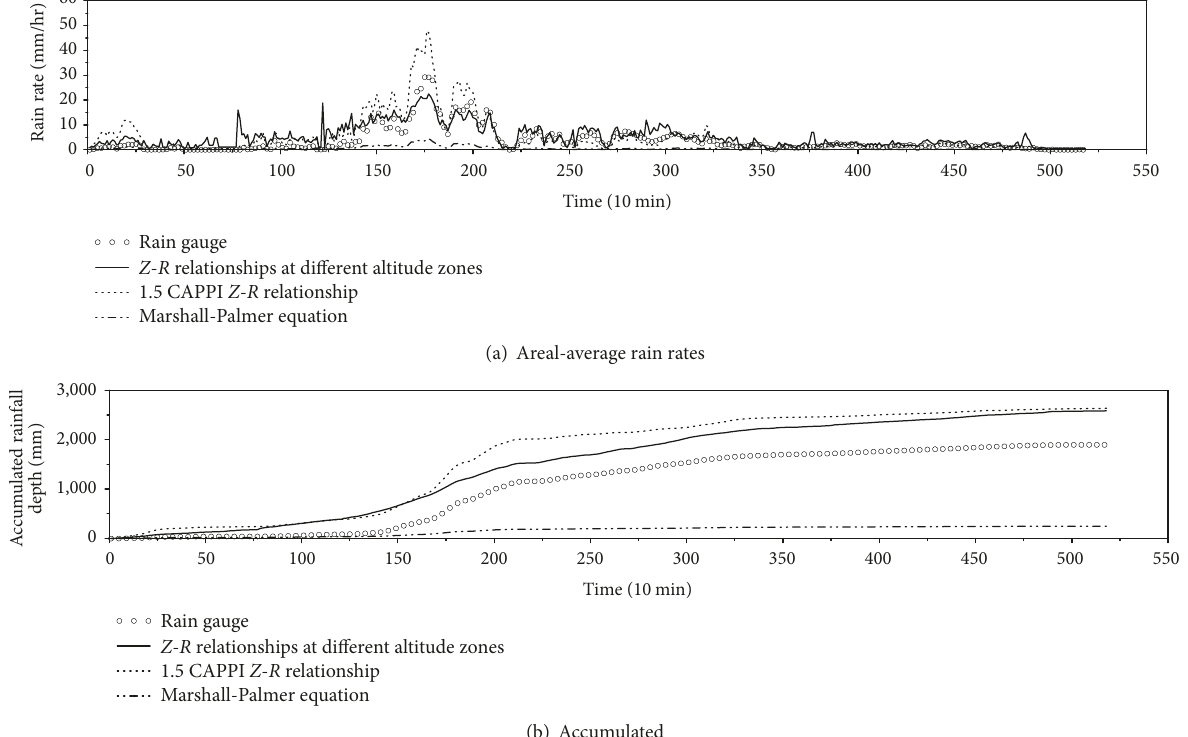
Figure 10: Comparison of (a) areal-average rain rates estimated by rain gauge, 𝑍 - 𝑅 relationships at difference altitude zones, 1.5km CAPPI 𝑍 - 𝑅 relationship and Marshall-Palmer equation, and (b) their accumulations.